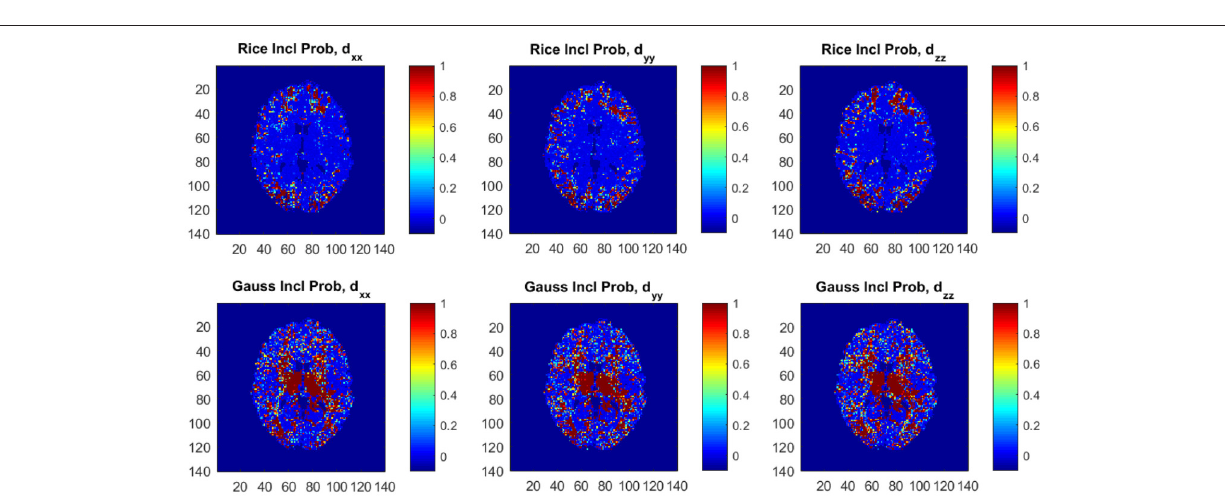
FIGURE 6 | Posterior inclusion probabilities for the variables corresponding to the diffusion directions